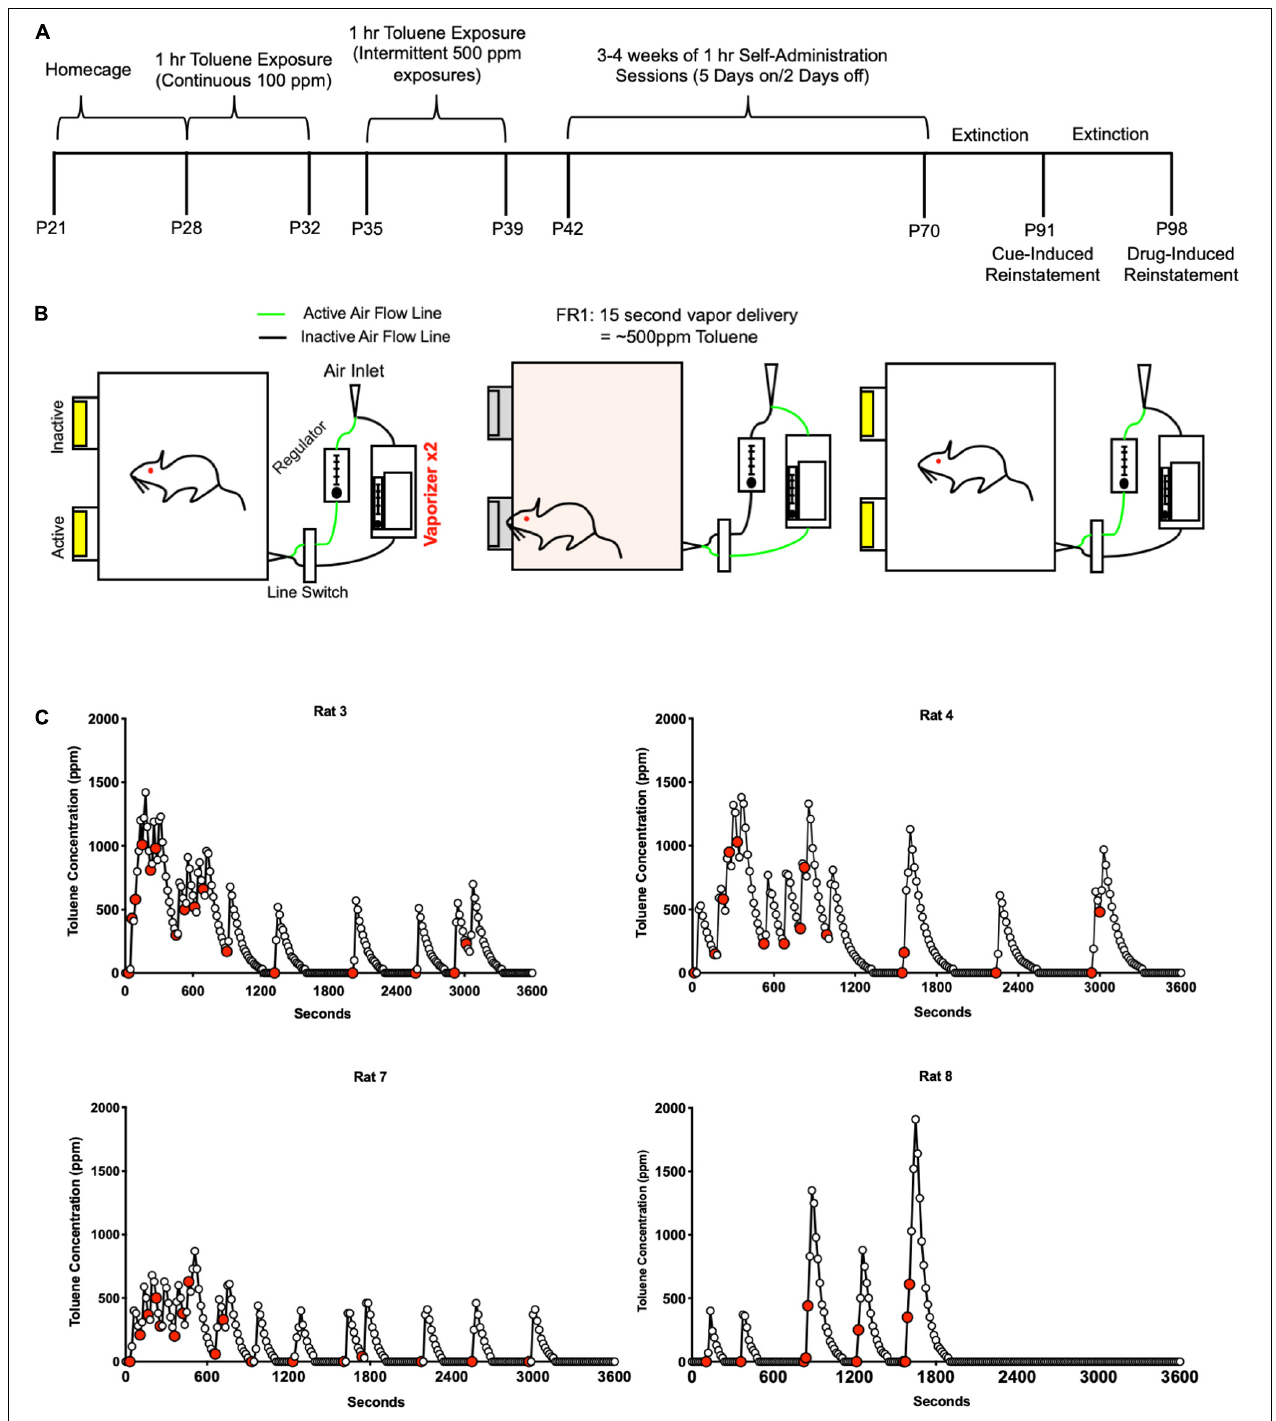
FIGURE 1 | Toluene self-administration protocol. (A) Timeline for acquisition, extinction, and reinstatement of operant responding for toluene vapor. (B) Illustration of the vapor SA apparatus. Active nose pokes triggered a 15 s exposure of air or toluene vapor while inactive nose pokes had no consequence. Additional responses during the 15 s drug delivery had no additional consequence. For Air SA and extinction sessions, the toluene vaporizers were replaced with a second air regulator. (C) Graphs show examples of 1 h self-administration sessions with toluene vapor concentrations measured every 15 s. Red filled symbols represent times of active vapor